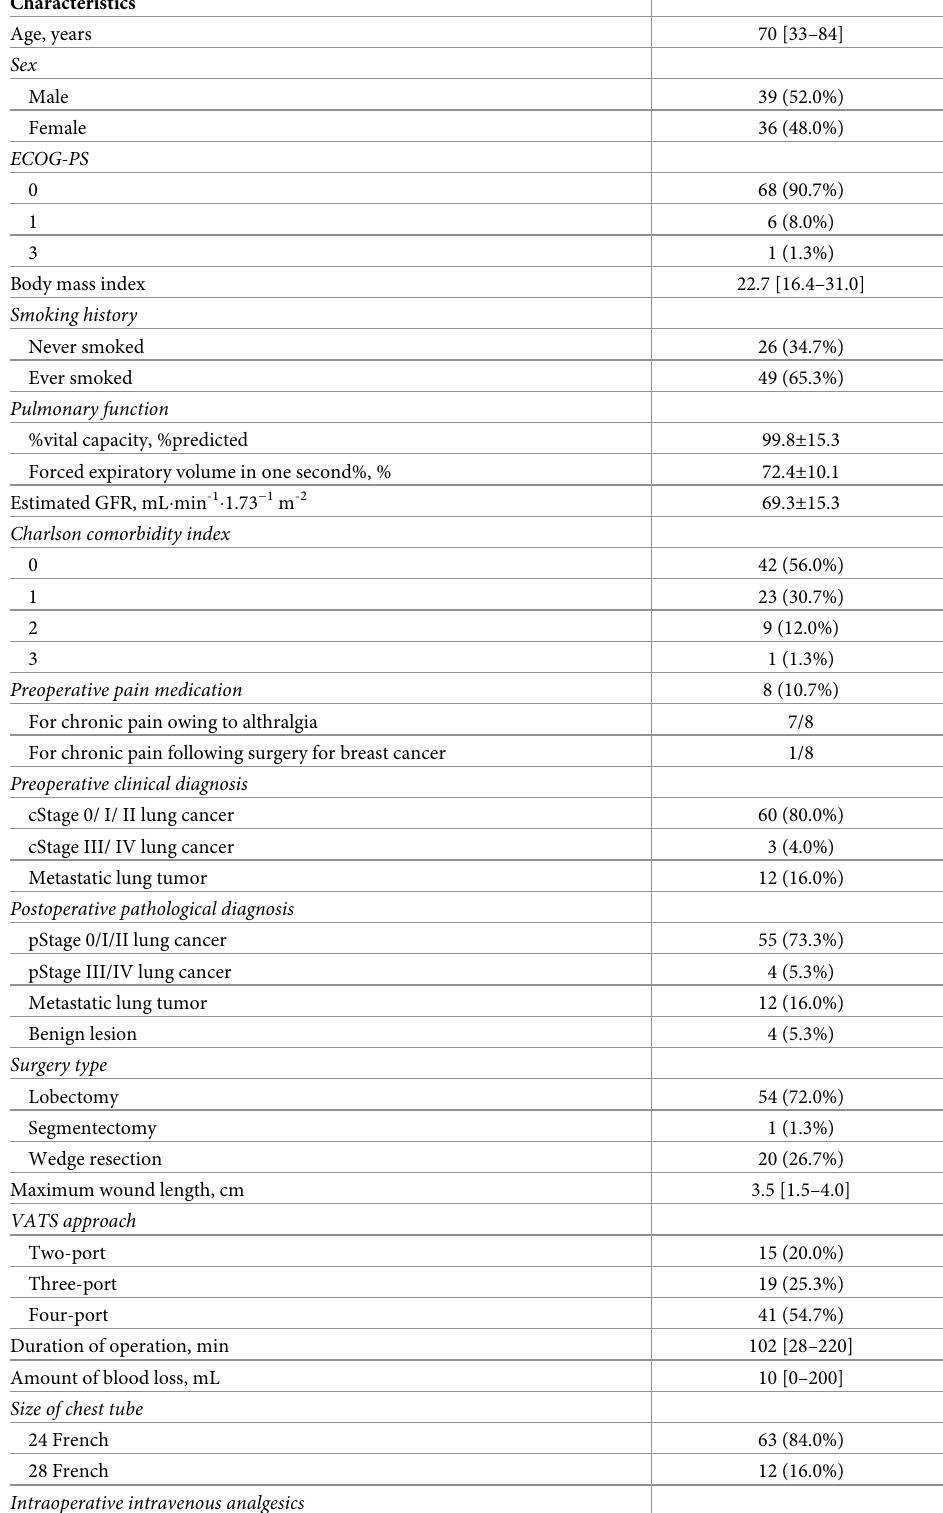
Table 1. Clinical and pathological characteristics of the patients (N =